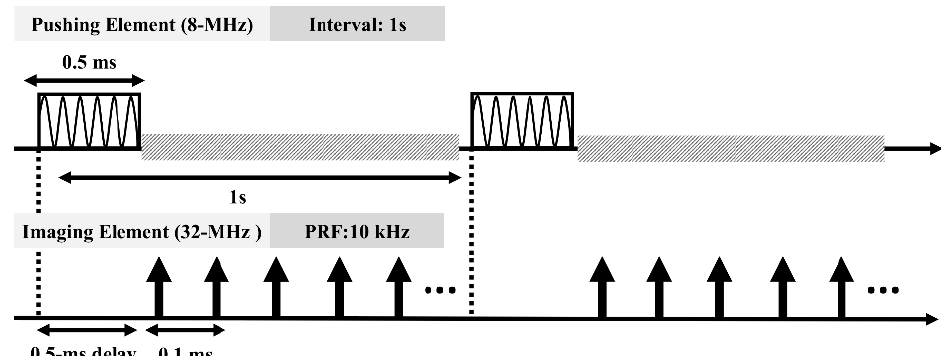
Figure 3. Timing diagram for the pushing and imaging sequences. A 500 µs tone burst was for the pushing elements to create s SW. To avoid the interference between pushing and imaging elements, the 500 µs delay was set before acquiring the data. The interval of 1s was used to synchronize the sequences of pushing and imaging elements.